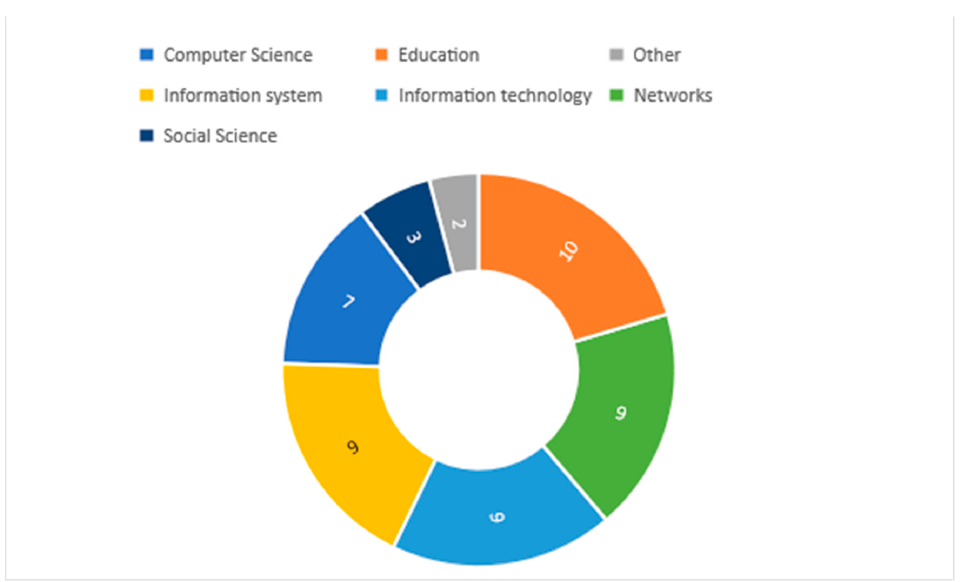
Figure 5. Subject distribution.